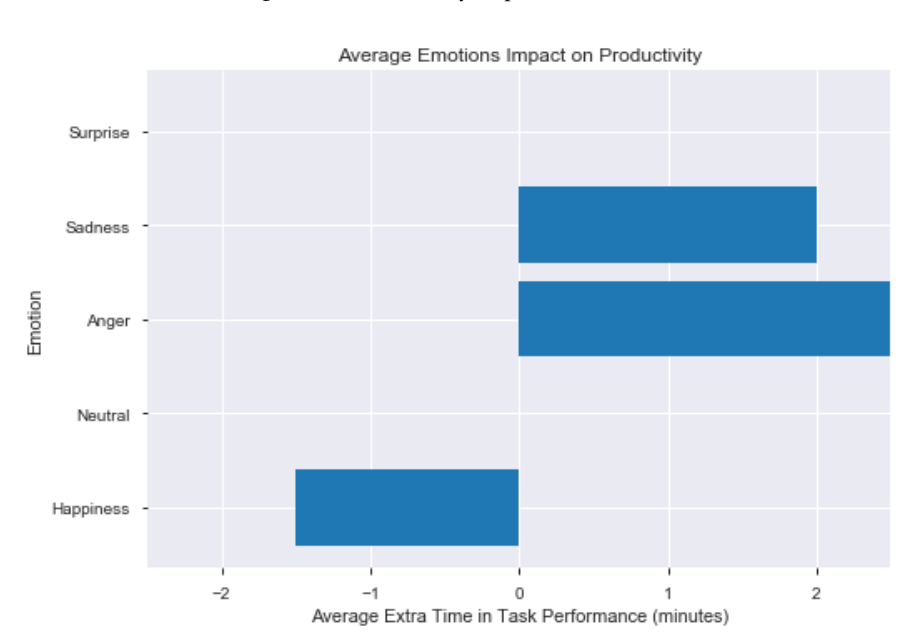
Figure 10. Productivity Impact of Emotions.